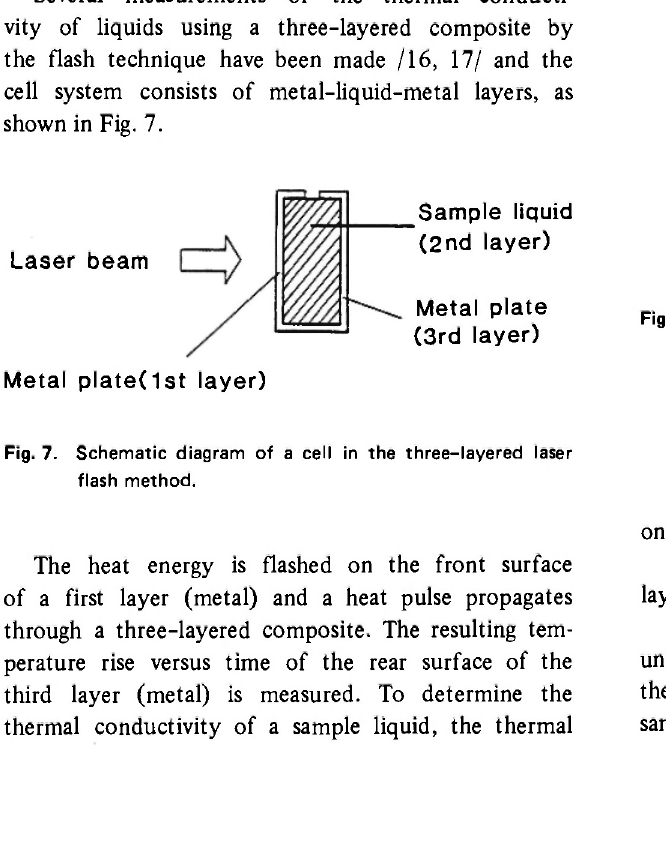
Fig. 8. Schematic diagram of a cell in the two-layered laser flash method 1221.